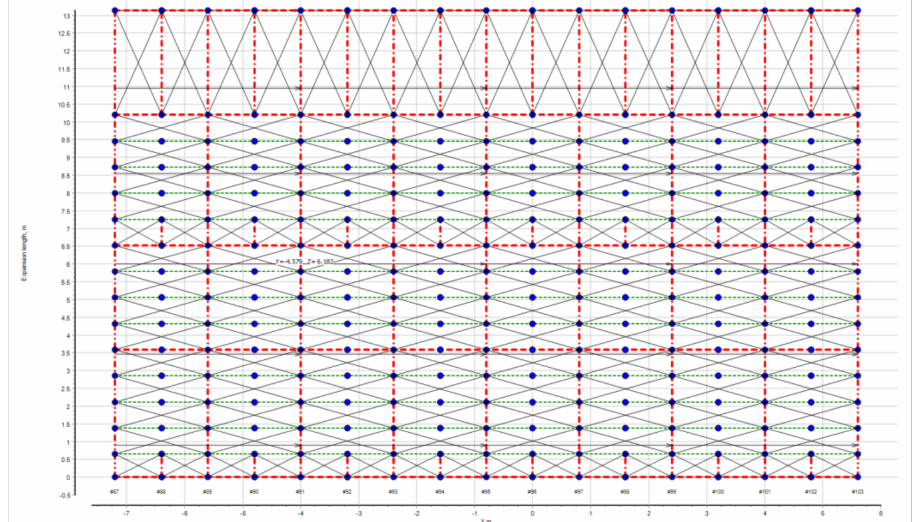
Figure 7. The result of the searching for panels for the bottom structures of the tanker. The primary supporting members and adjacent structures are shown in red, the stiffeners are shown in green. Blue dots are nodes from the matrix shown in Figure